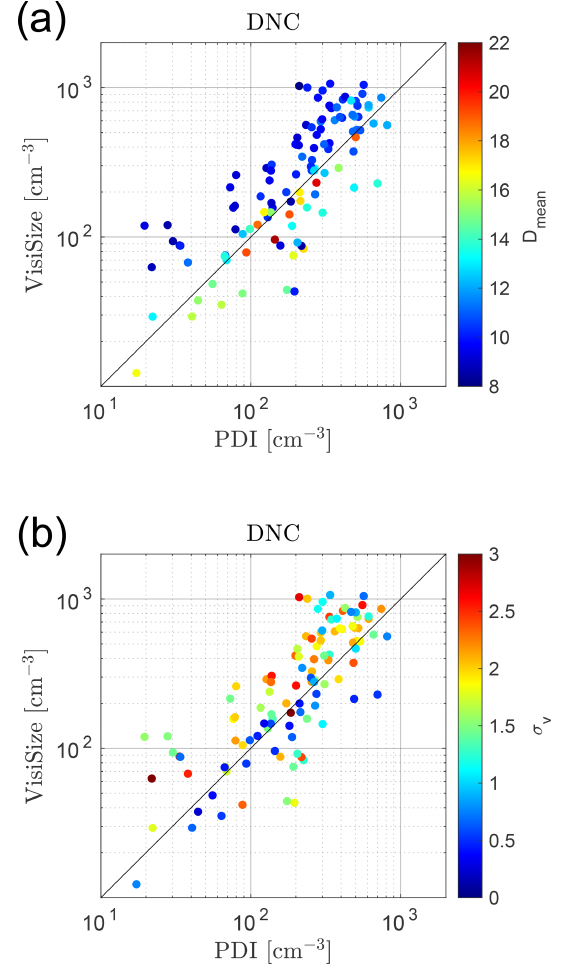
Figure 12. The DNC comparison between the two instruments, with the mean diameter spectra (a) and the standard deviation of velocity spectra (b) compared between the selected cases. The results after applying all modifications and filters to the data and with applica- tion of the PVC factor to the modified PDI swept volume method are used here. The mean diameters and the velocity standard devi- ations are calculated using the VisiSize and PDI data, respectively. Each circle represents a single measurement of ∼